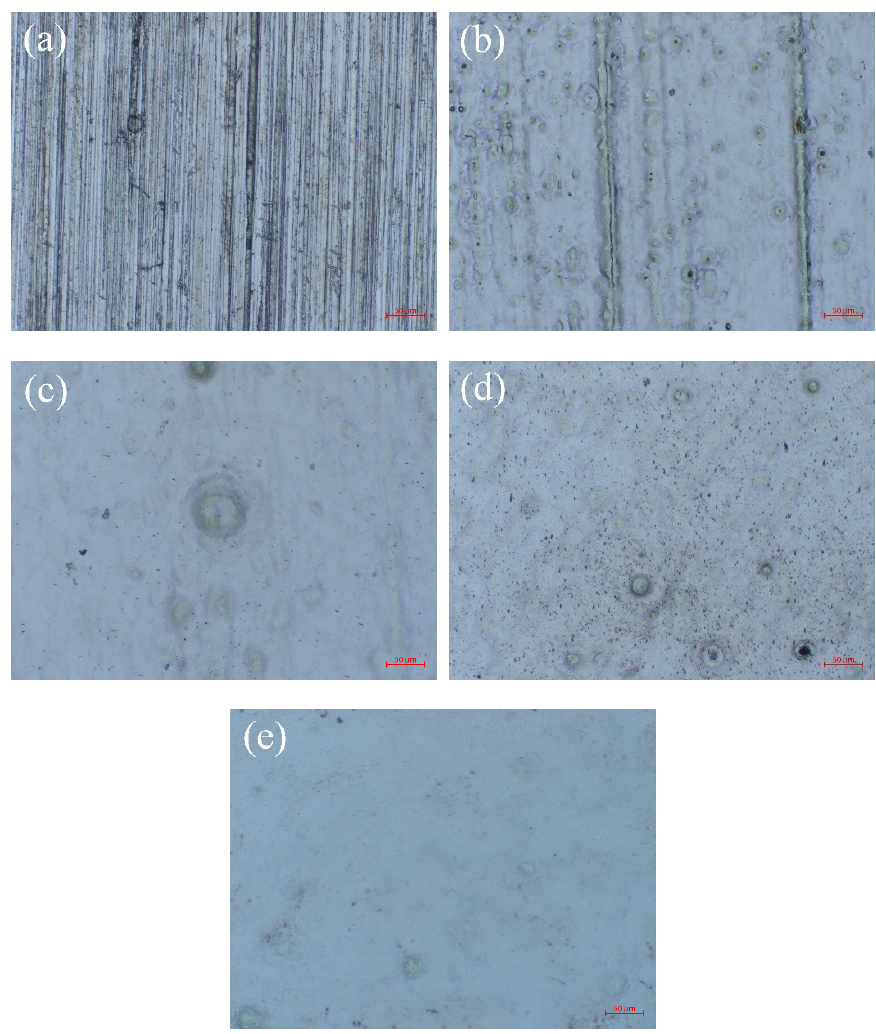
Figure 3. Surface morphology of IN718 alloy: ( a ) original; under IPIB with current density of 200 A/cm 2 , ( b ) 1 pulse; ( c ) 5 pulses; ( d ) 10 pulses; ( e ) 20 pulses. The scale mark on the lower right corner stands for 50 μ m.